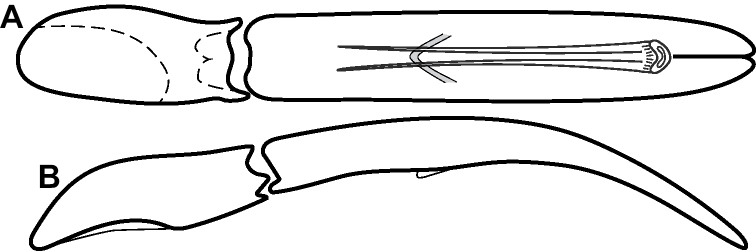
Male genitalia, Phelister
incertusA aedeagus, dorsal B aedeagus, lateral.